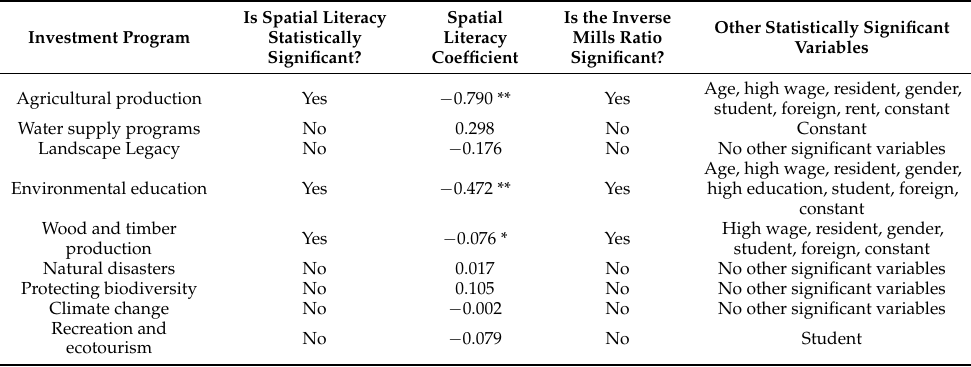
Table 6. Results for two-stage model. The second stage is an Ordinary Least Square regression on the magnitude of investment for a respondent. By including the Inverse Mills Ratio in the regression, we control for the probability that a respondent selects a given